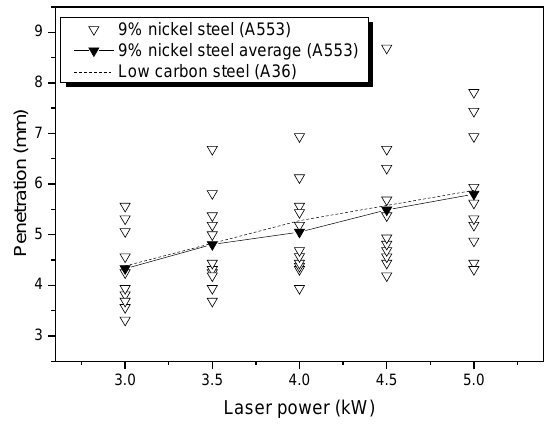
Figure 11. Penetration fluctuation of surface beads, according to laser power.